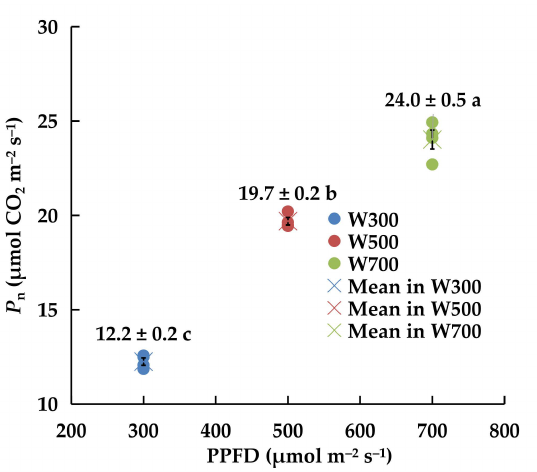
Figure 2. Effect of PPFD on net photosynthetic rate (Pn) of leaves in ‘Micro-Tom’ 10 DAT in Ex- periment 1. Four plants were measured for each PPFD. Solid point denotes the measured value for one plant. X-mark represents the average Pn of four plants in each treatment. Error bars rep- resent ± standard error. Different letters indicate significant differences among the treatments based on Tukey − Kramer’s test at p < 0.05 ( n = 4). W300, W500, and W700 denote 300, 500, and 700 µ mol m − 2 s − 1 PPFD, respectively.